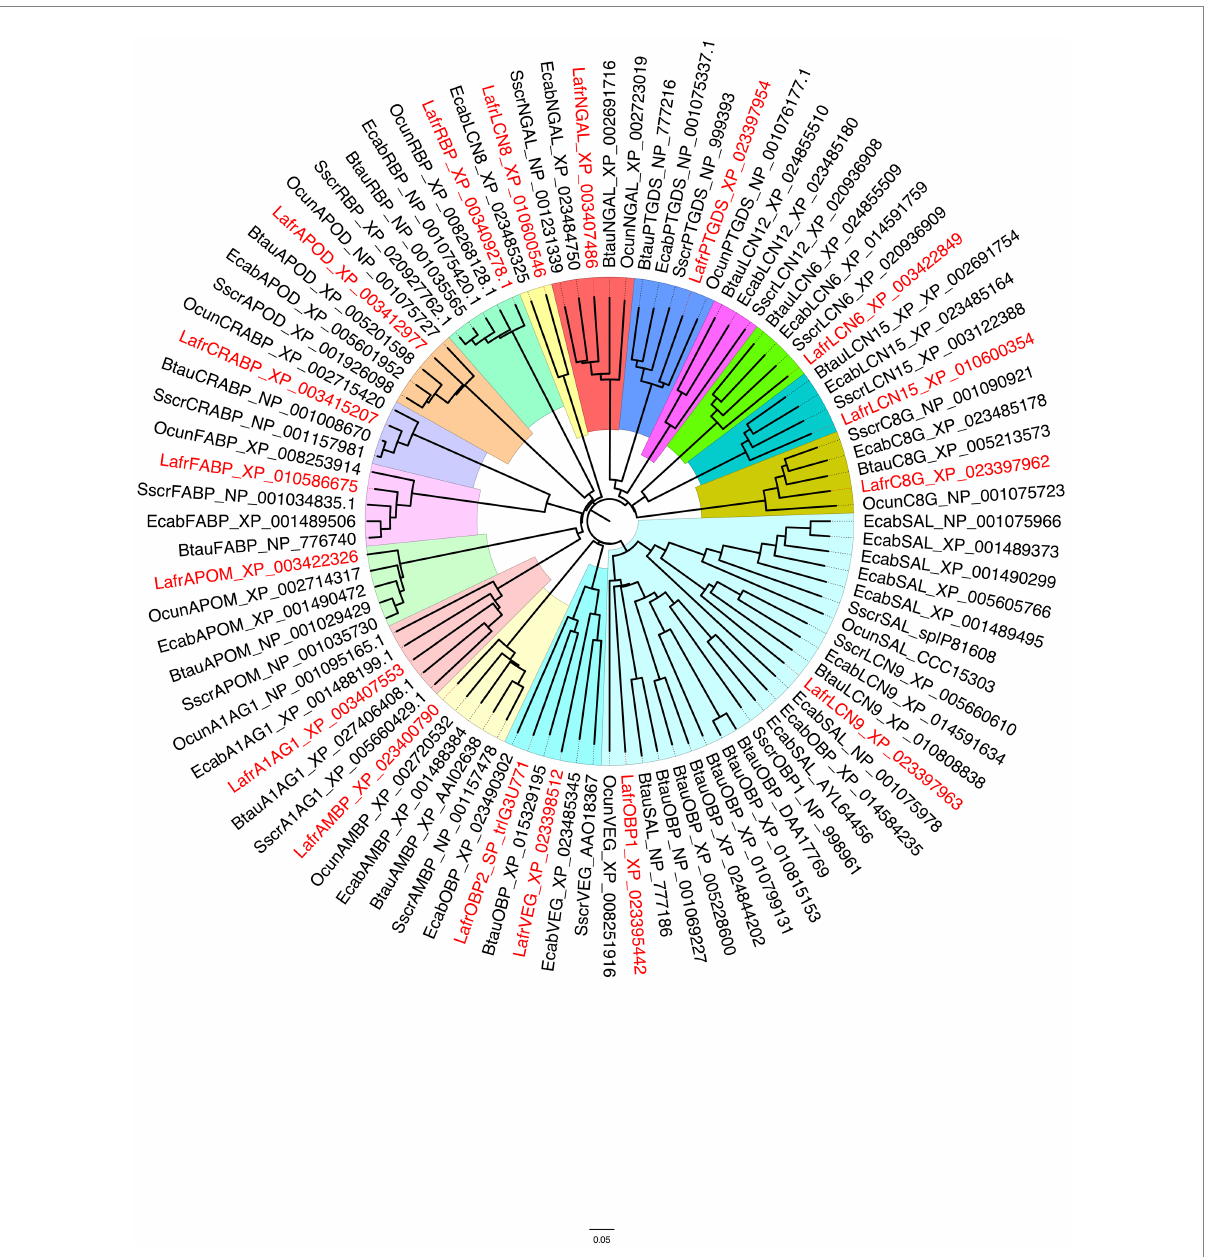
FIGURE 1 Phylogenetic tree of lipocalins from the African elephant, Loxodonta africana (Lafr), shown in red, compared with orthologues from other mammalian species. Sscr, Sus scrofa; Btau, Bos taurus; Ecab , Equus caballus; Ocun, Oryctolagus cuniculus . Different lipocalins are shaded with different colours. A large clade (pale blue) represents the group of OBPs and SALs, but also includes lipocalin 9 sequences, whose function has not been investigated. Another clade, to which LafrOBP2 belongs, contains lipocalins classified as VEGs (turquoise). Some of these proteins have been reported to perform a bacteriostatic function, but other members may act as semiochemical carriers. OBP, Odorant-binding protein; VEG, von Ebner gland; AMBP, Alpha-1-microglobulin; NGAL, Neutrophil gelatinase-associated lipocalin; PTGDS, Prostaglandin D synthase; C8G, Complement C8 gamma chain; APOD, Apolipoprotein D; RBP, retinol-binding protein; A1AG1, Alpha-1-acid glycoprotein; APOM, Apolipoprotein M; CRABP, Cellular retinoic acid binding protein; FABP, Fatty acid binding protein; LCN,